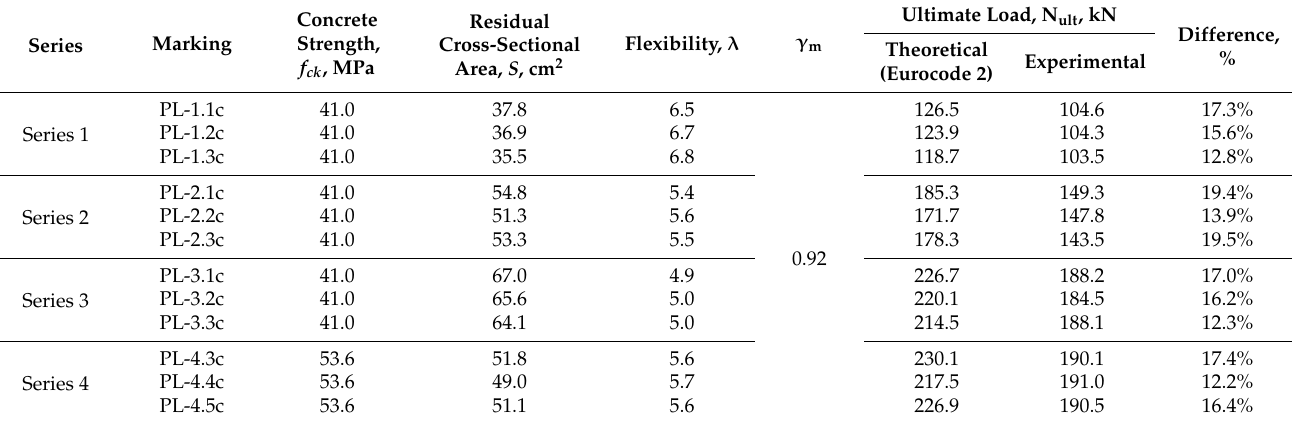
Table 3. Strength of concrete prisms subjected to simultaneous action of loading and the aggressive environment.